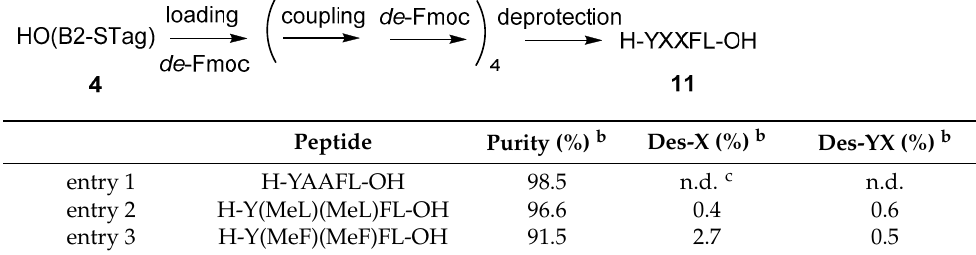
Table 4. Synthesis of successive N -methylated peptides a .